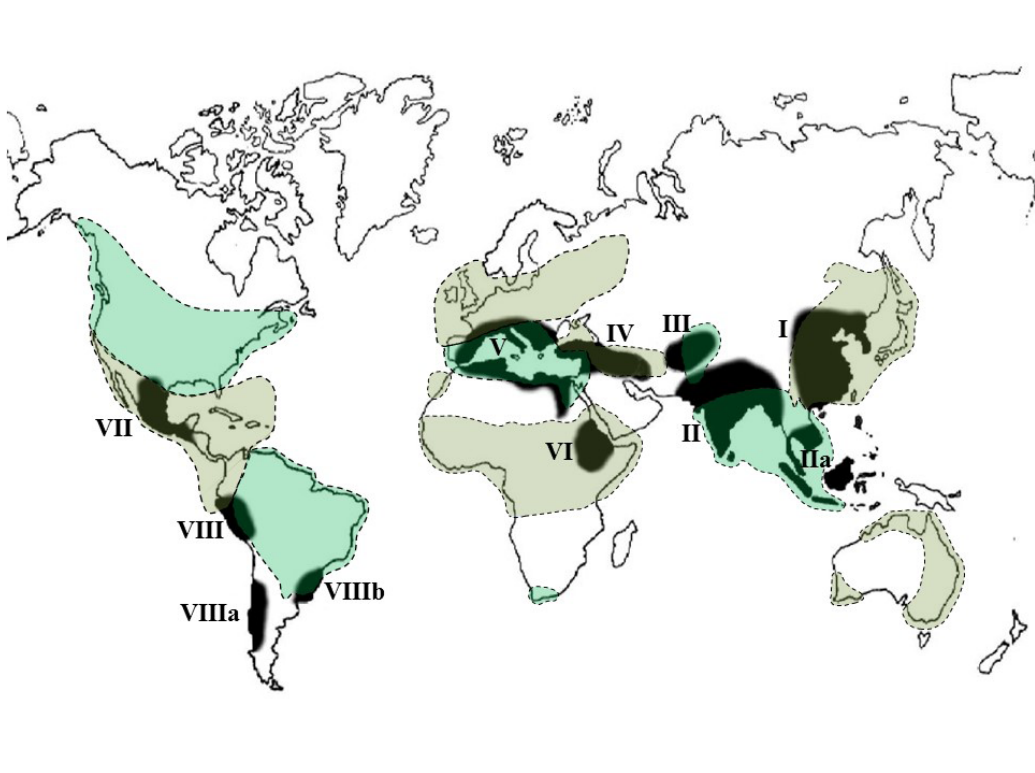
Figure 1. Thirteen regions of origin of ornamental species superimposed over Vavilov’s original eight geographic centers of origin of cultivated food and economically important crop species (Vavilov 1926; 1935; 1992). The 13 regions are delineated with dashed lines and filled with different shades of green for clarity of distinction. The 13 regions of origin of over 4,500 ornamental plants were developed by researchers at Missouri Botanical Garden, and are similar and overlap the twelve mega centers of cultivated plants described by Zeven and Zhukovsky (1975) for cultivated plants excluding ornamentals, forest trees, and lower plants. (http://www.mobot.org/MOBOT/Research/